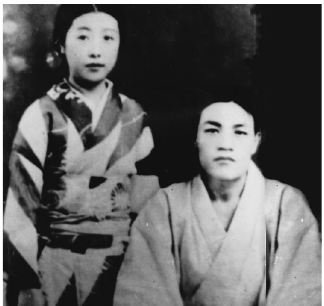
Figure 1. Prof. Yongjia Duan and his wife.